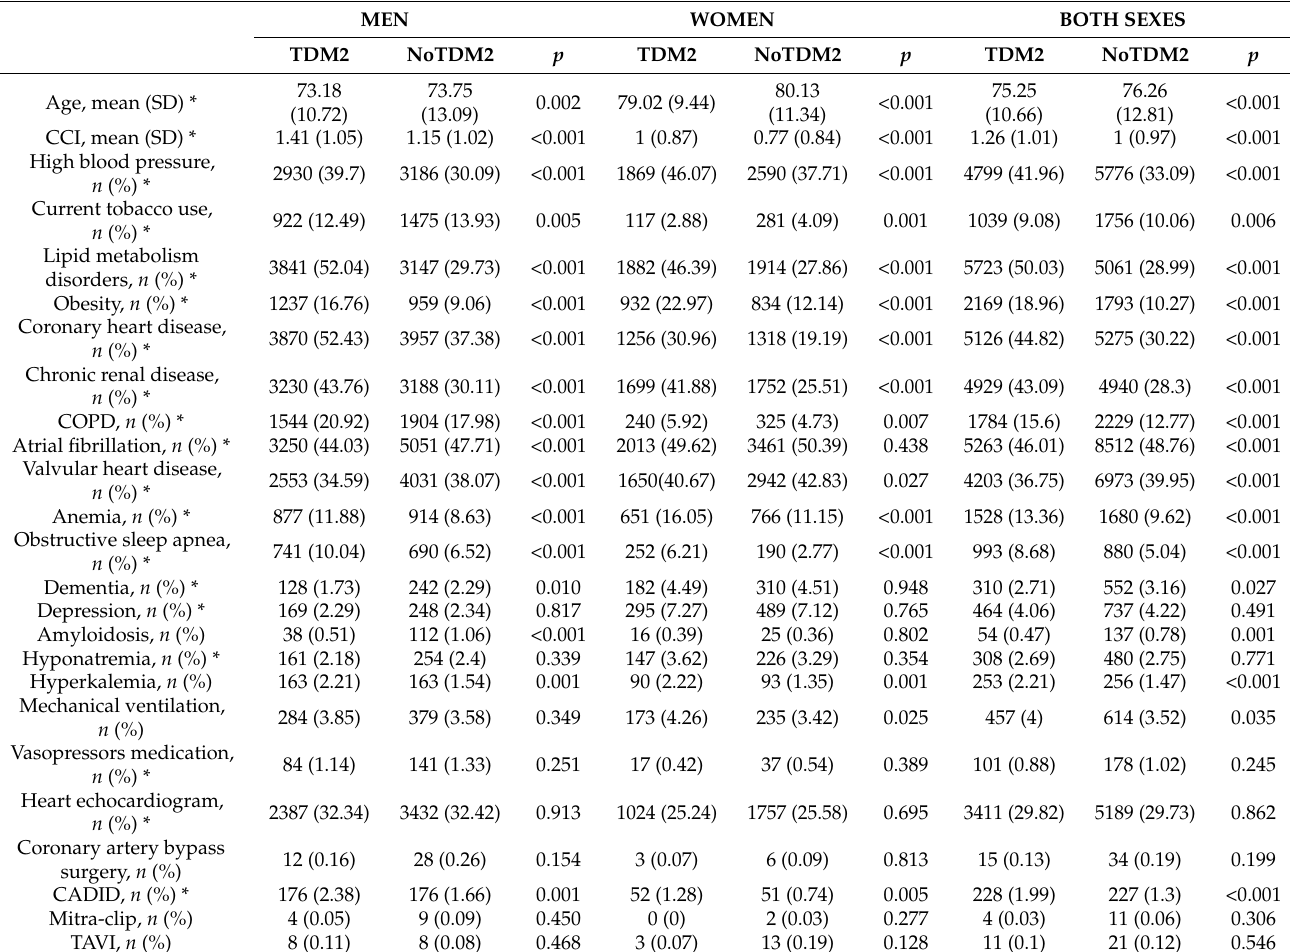
Table 1. Demographic and clinical characteristics of subjects hospitalized with systolic heart failure in Spain from 2016 to 2019 according to sex and the presence of type 2 diabetes